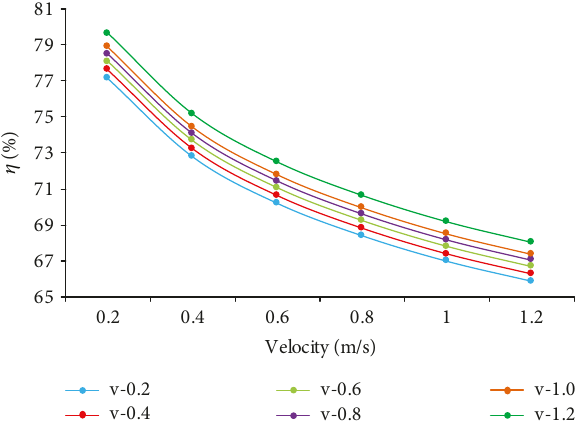
Figure 19: E ff ect of inlet velocity of HTF on heat storage e ffi